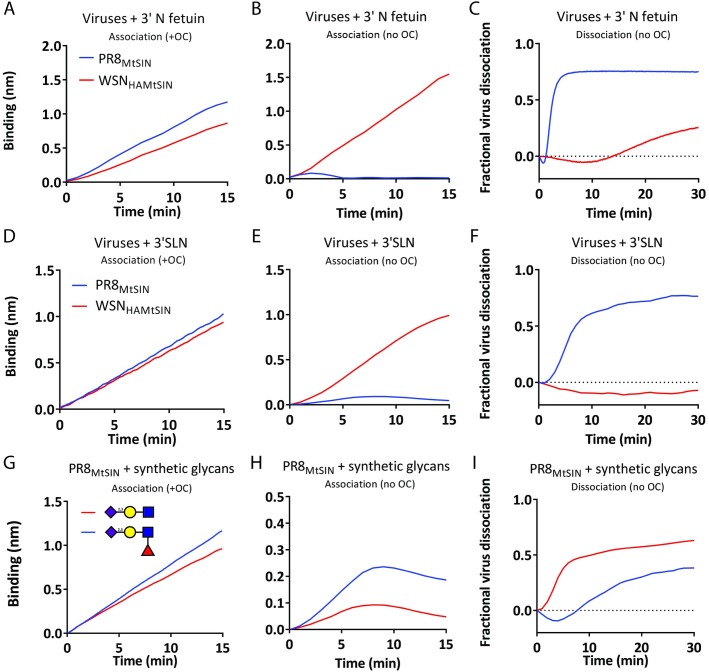
NA specificity affects the HA/NA balance.PR8MtSIN and WSNHAMtSIN, both carrying the same HAMtSIN but either NAMtSIN (high NA activity) or NAWSN (low NA activity), respectively, were bound at 30 pM concentration to biotinylated 3’SLN or Fc-tagged 3’N Fetuin loaded to maximum level in the presence (A, D) or absence (B, E) of 10 μM OC. Viruses bound to sensors in presence of OC (A, D) were washed three times in PBS and subsequently examined for NA activity-dependent self-elution in absence of OC (C, F). Virus dissociation in panel C and F is plotted on the positive Y-axis as fraction of virus released relative to the binding level reached in panel A and D respectively. Biotinylated 3’SLN or its fucosylated derivative (SLeX, NeuNAcα2,3Galβ1,4(Fucα1,3)GlcNAc) were loaded to maximum levels on SA sensors and bound with 30 pM PR8MtSIN in the presence (G) or absence (H) of 10 μM OC for 15 minutes. After three washes in PBS the sensors loaded with virus in (G) were incubated in PBS without OC to allow determination of virus self-elution due to NA activity (I).